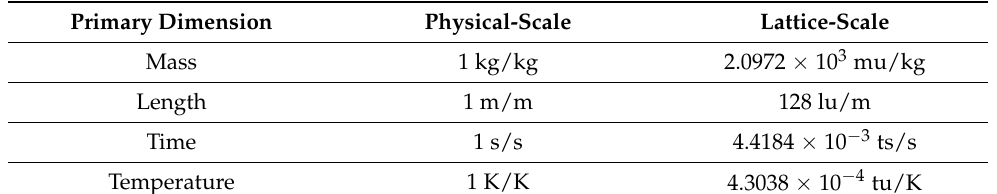
Table 10. Scaling units between SI and lattice systems.